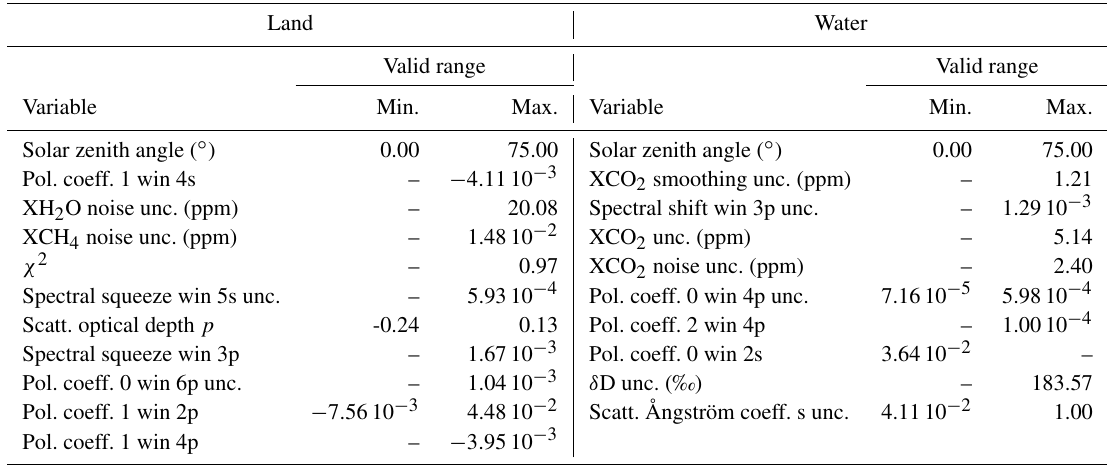
Table A3. XCH 4 Proxy filter variables and limits for GOSAT. “–” means that no limit is applied. Except for the solar zenith angle limits, the variables are ordered by their relevance, i.e. by the number of data filtered out.